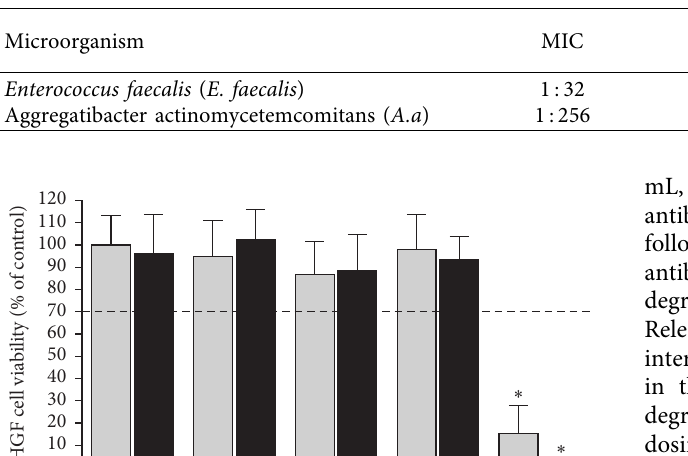
Table 1: Antibacterial activity: the results of the released PMC from PPCMs on “ Enterococcus faecalis ( E .faecalis )” and “ Aggregatibacter actinomycetemcomitans ( A.a ).”